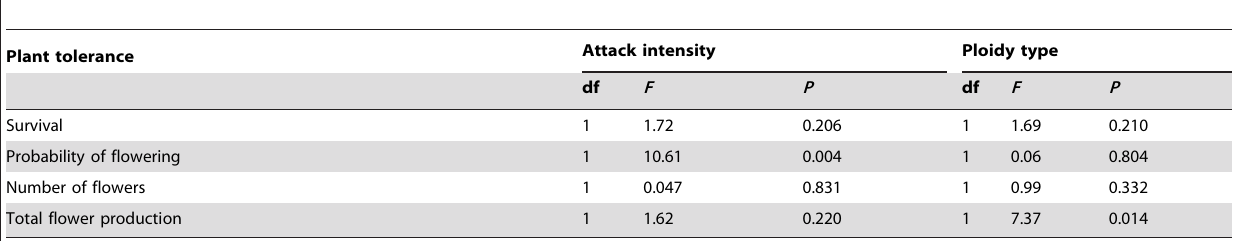
Table 3. Relationship between four estimates of plant tolerance to herbivory and attack intensity in the field and ploidy type in the herb Cardamine pratensis .